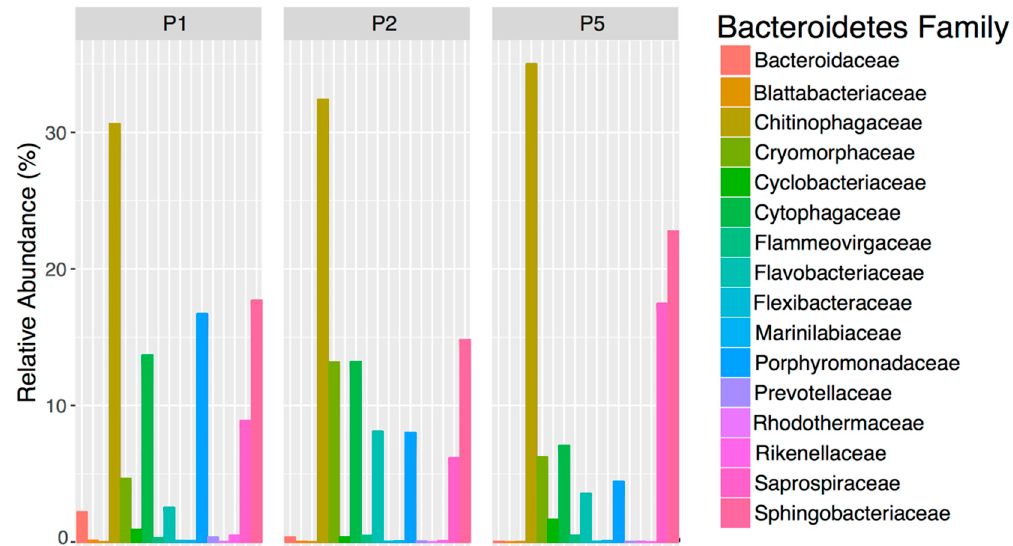
Figure 7. Relative abundance (%) for the 16 Bacteroidetes families. Family-level relative abundances are calculated for the Bacteroidetes phyla only, not relative to all the bacterial taxa measured. See Appendix A Table A6 for the relative abundance values. P1 = Pond 1, P2 = Pond 2 and P5 = Pond 5.